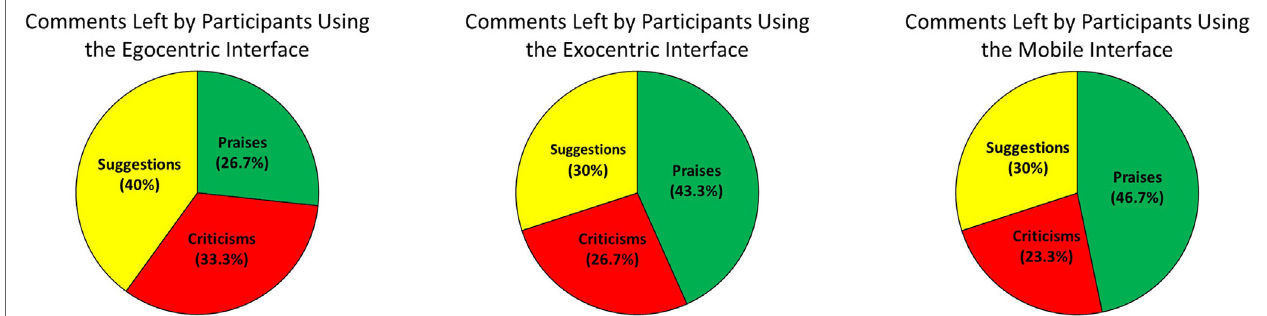
FigUre 14 | Percentage of each type of comment left by participants for each interface used in the study